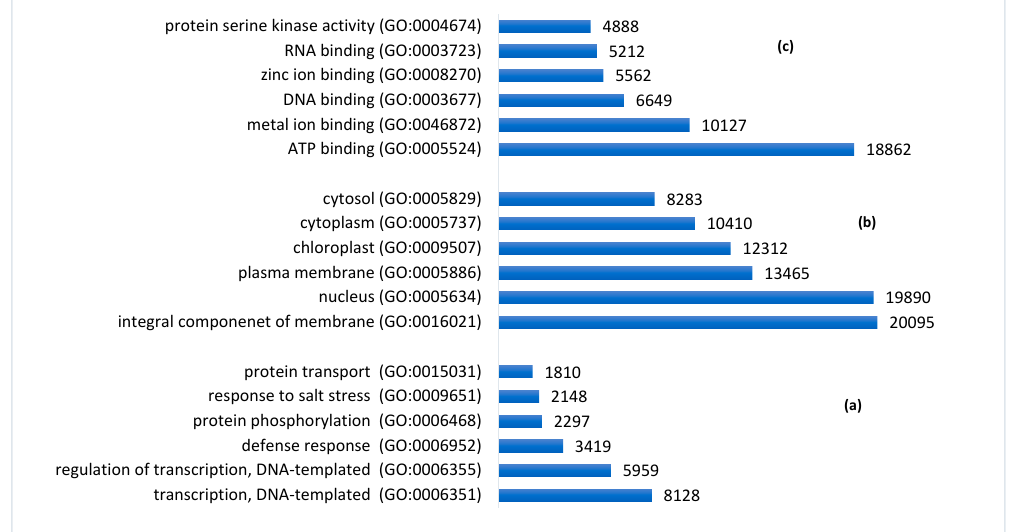
Figure 2. Gene Ontology (GO) classification of A. marmelos transcripts. GO term are divided in three main categories: biological process ( a ), cellular component ( b ), and molecular function ( c ).